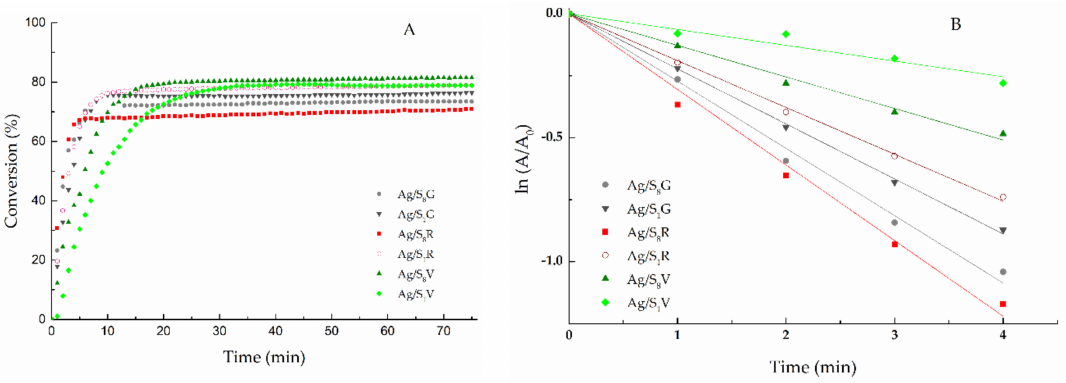
Figure5. Catalyticactivityofthedi ff erentbionanocatalysts. ( A )Conversionvs. time. ( B )ln ( A t / A 0 ) vs. t . The K app values were obtained using Equation (4).